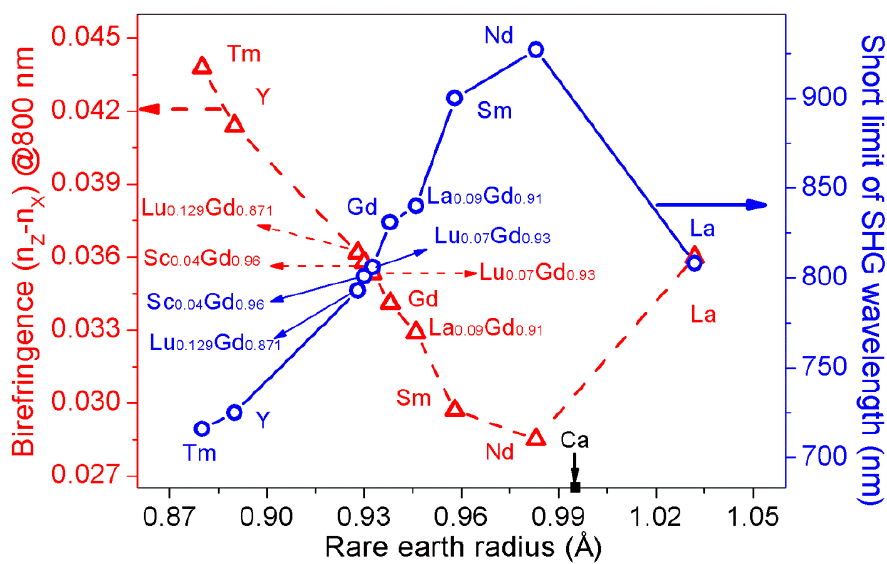
Figure 1. Variation of birefringence and short limit of SHG wavelength with the rare-earth ion radius in RECOB crystals.